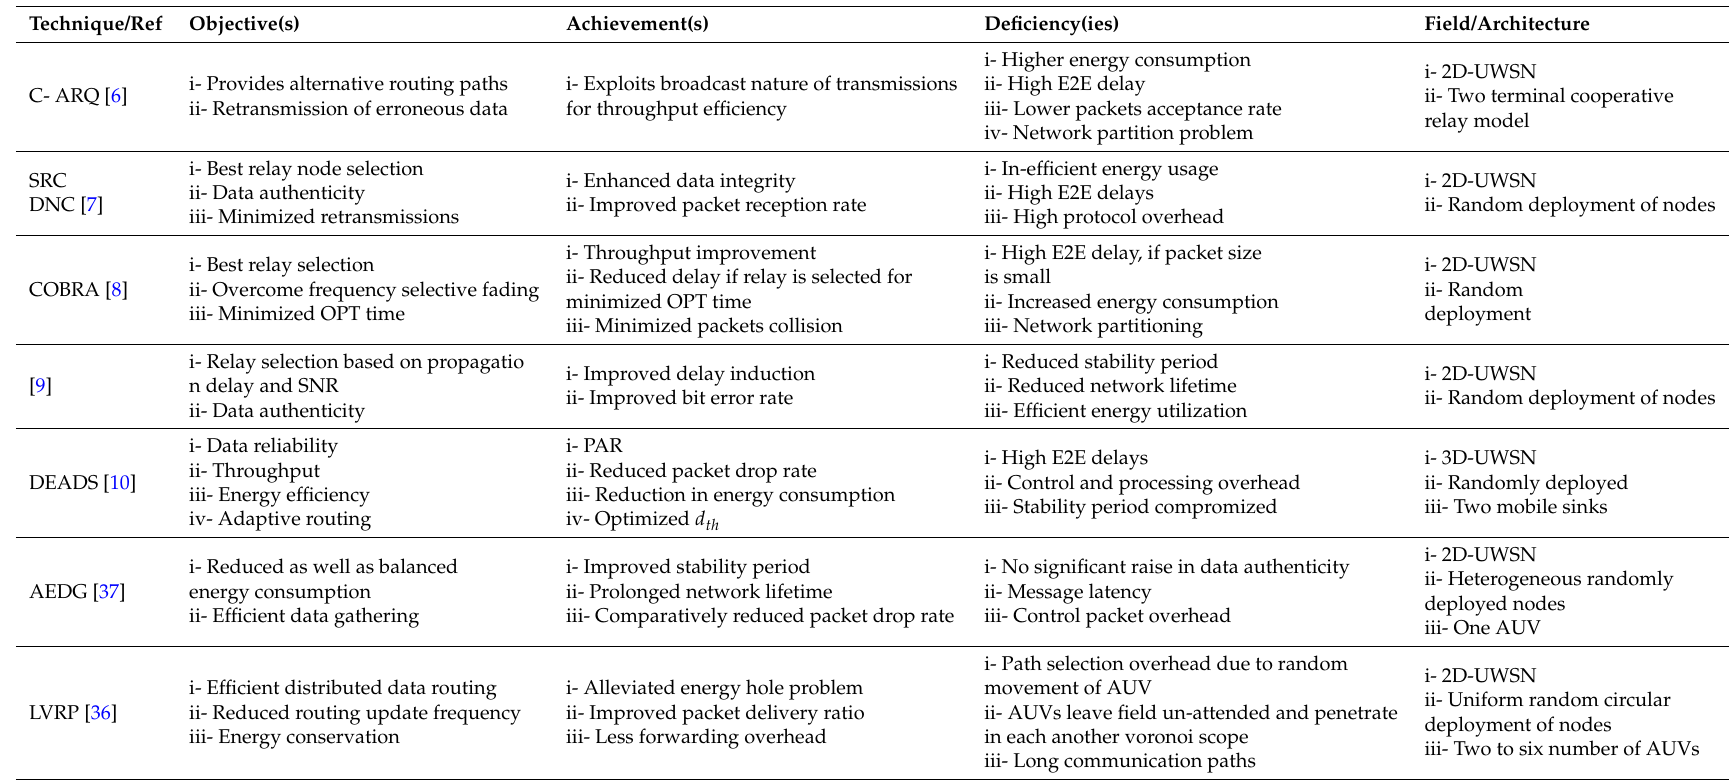
Table 1. Comparison of the state-of-the-art